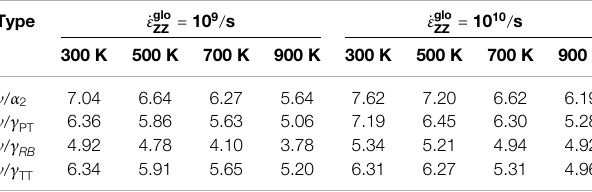
TABLE 2 | Yield stress of Type-2 models for different temperatures and interface types at strain rates of _ ε glo ZZ (cid:2) 10 9 / s and _ ε glo ZZ (cid:2) 10 10 / s